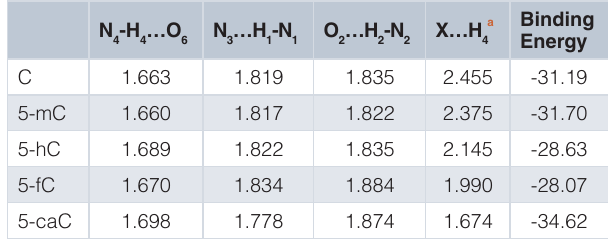
Table 1. Hydrogen bond lengths and binding energies of CG Watson-Crick base pairs from B97-D/def2-TZVP (Å and kcal/mol).